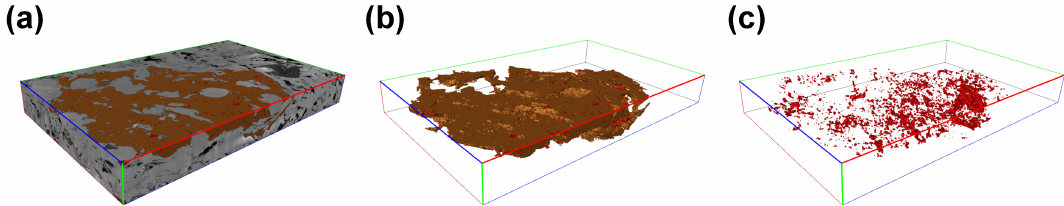
Figure 4. The analysis of the biggest organic cluster of sample HAD revealed that organics contain small unconnected pores. A total porosity of 5.5% was observed within the cluster. These pores are formed during the thermal maturation of the shale.